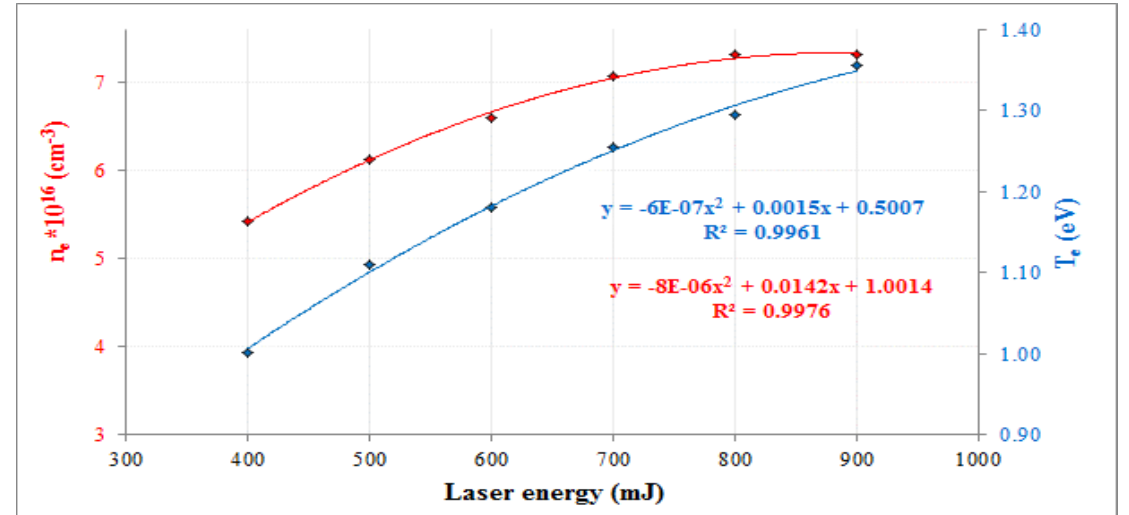
Fig.9: The variation of T